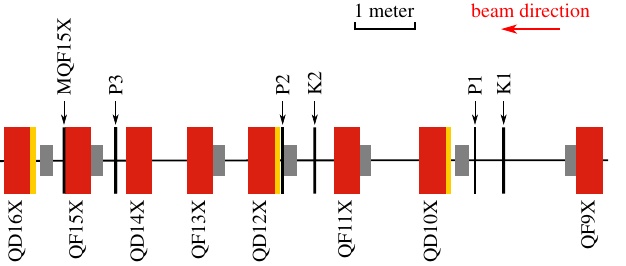
FIG. 7. Layout of the stripline BPMs (P1, P2, P3, and MQF15X) and kickers (K1 and K2) used in the FONT system. Quadrupole magnets ( “ Q ” ) are shown in red, skew quadrupoles in yellow, and correctors in gray.